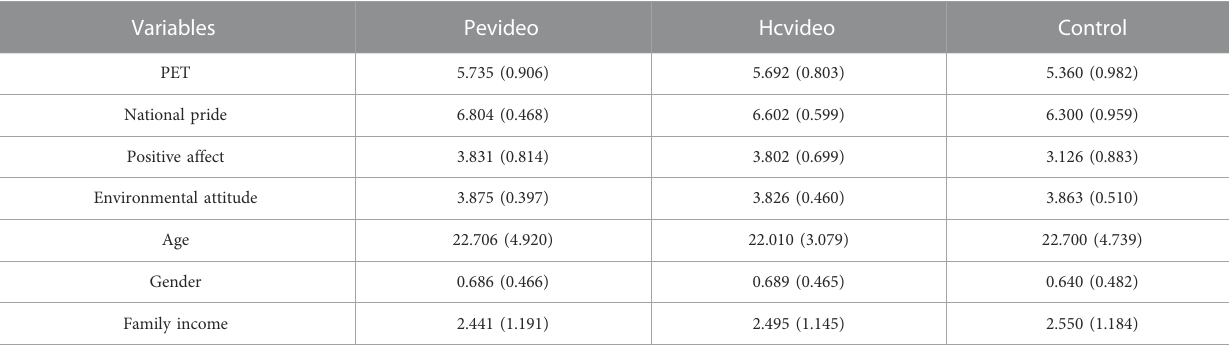
TABLE 2 Descriptive statistics in Study 2.